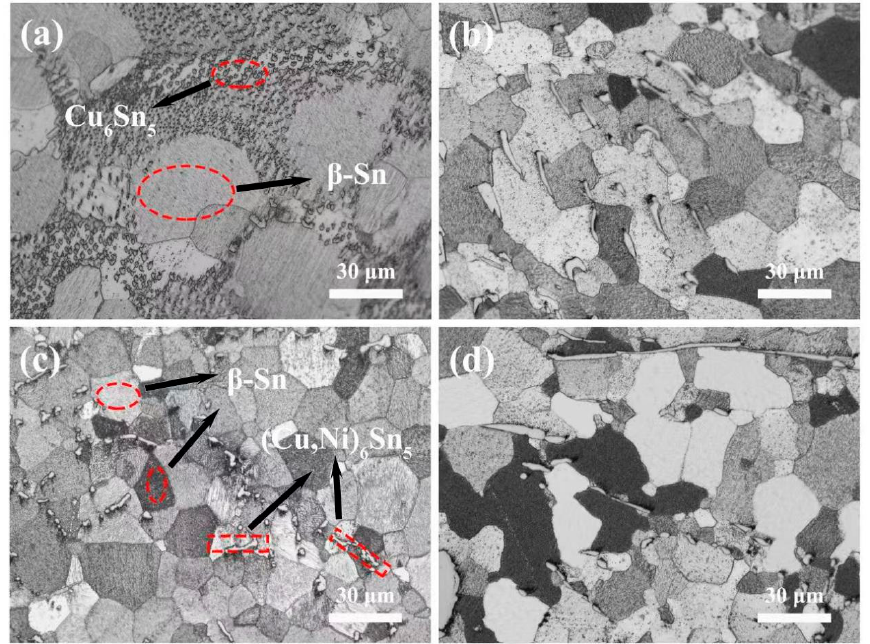
Figure 5. Metallographic microstructure diagram of Sn-0.7Cu- x Ni@C composite solder: ( a ) x = 0, ( b ) x = 0.04, ( c ) x = 0.08, ( d ) x = 0.12 wt.%.